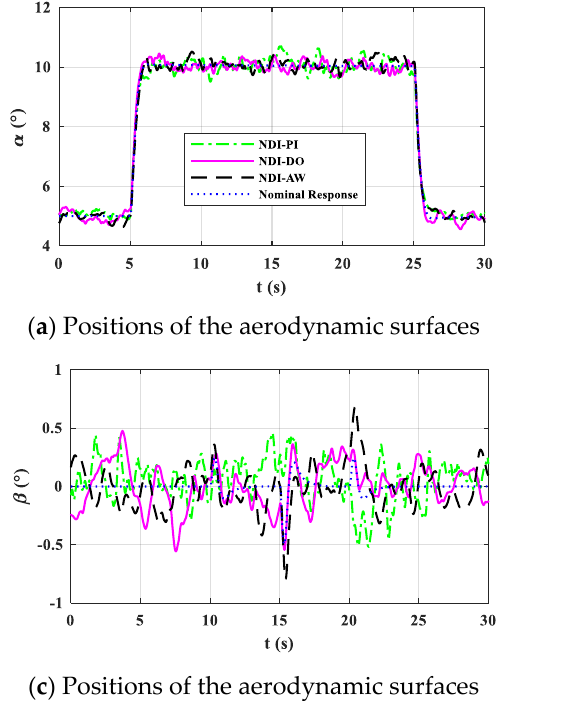
Figure 7. Response of the tailless aircraft model controlled using NDI-PI, NDI-DO, and NDI-AW with the sensor noise.